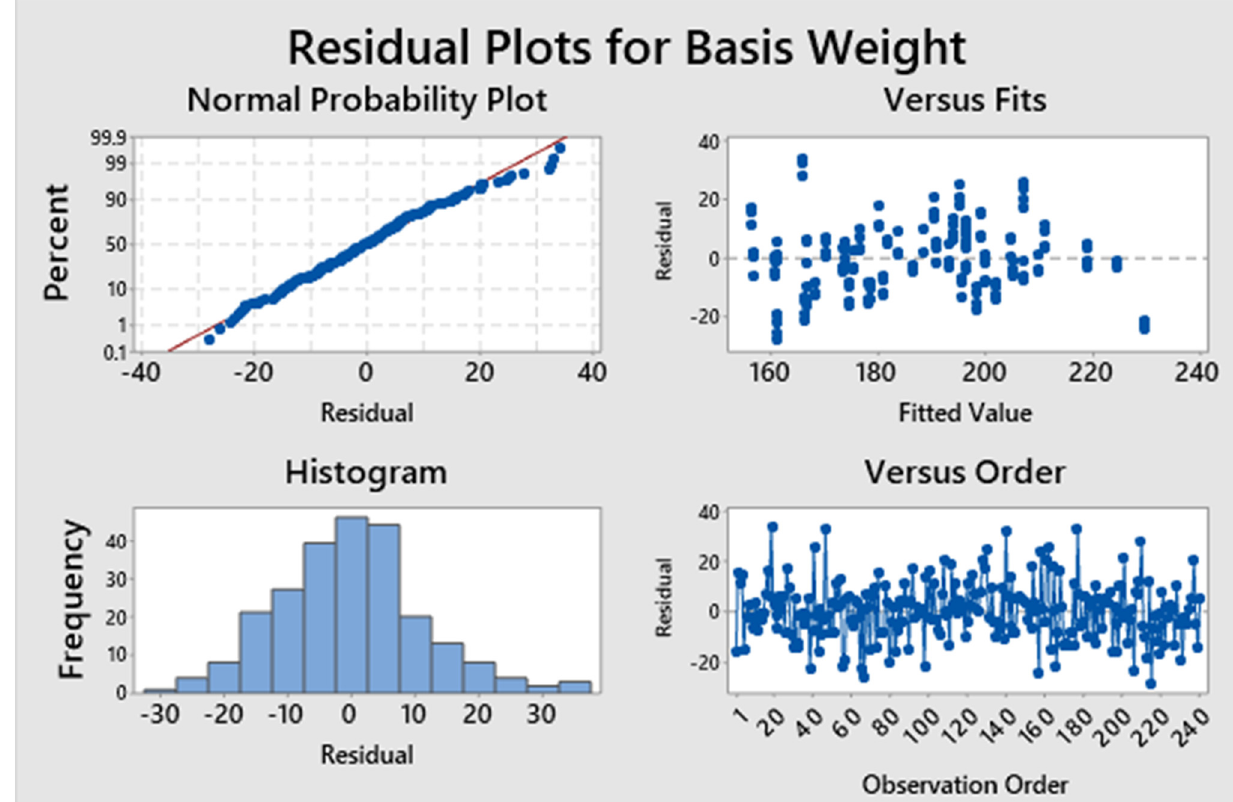
Figure 9. Model assumption for the experimental designs.